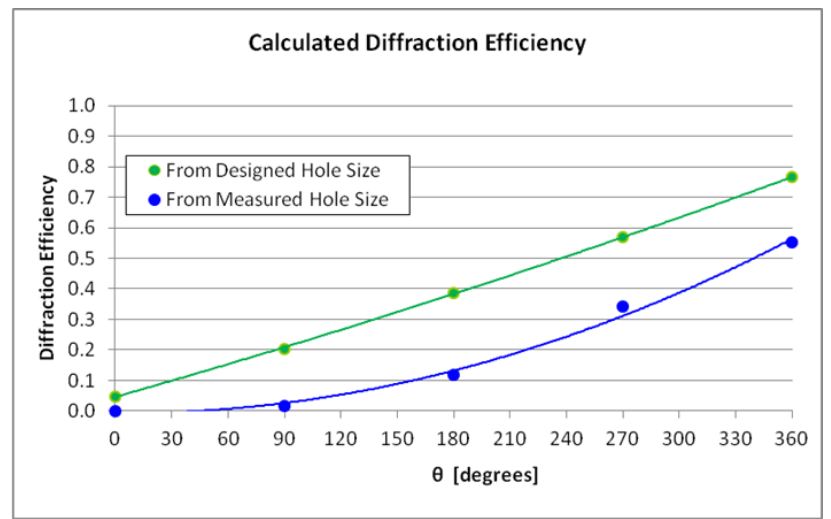
Figure 13. Graph Showing the Diffraction Efficiency of the Phase